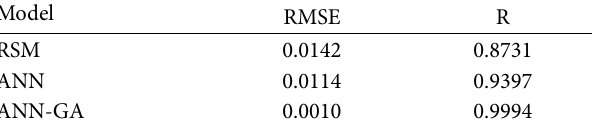
Figure 7: Predicted values versus the actual values, (a) RSM, (b) ANN, (c) Table 5: Statistical parameters of RSM, ANN and ANN-GA model.